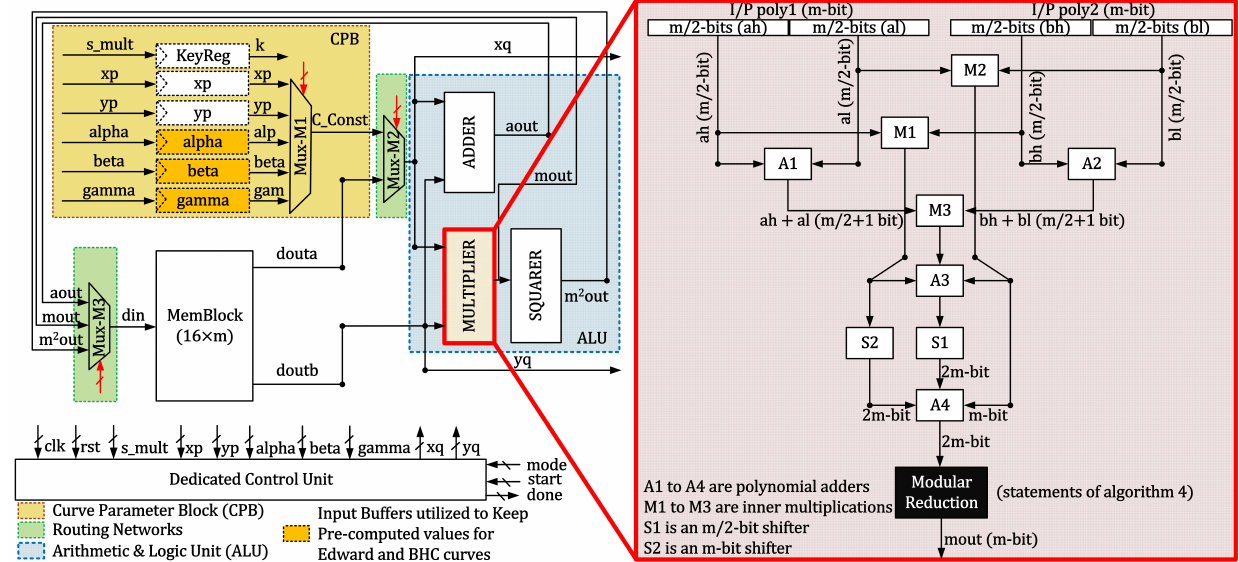
Figure 1. FPGA comparison with most recent PM architectures of the Weierstrass, Edward, and Huff